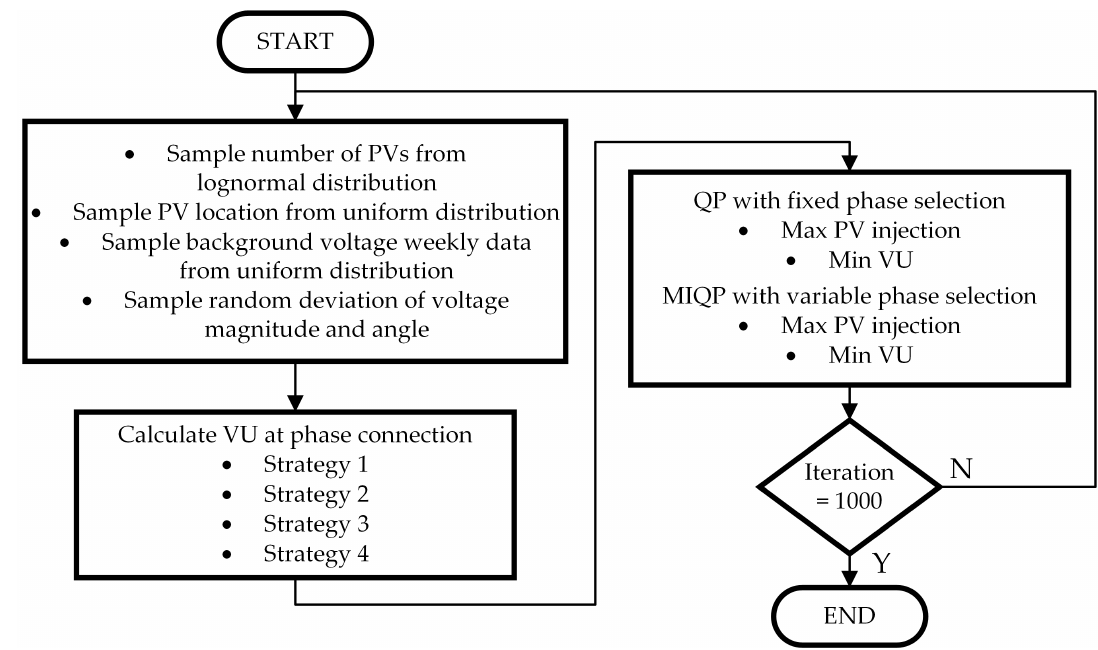
Figure 4. Flowchart of the Monte Carlo